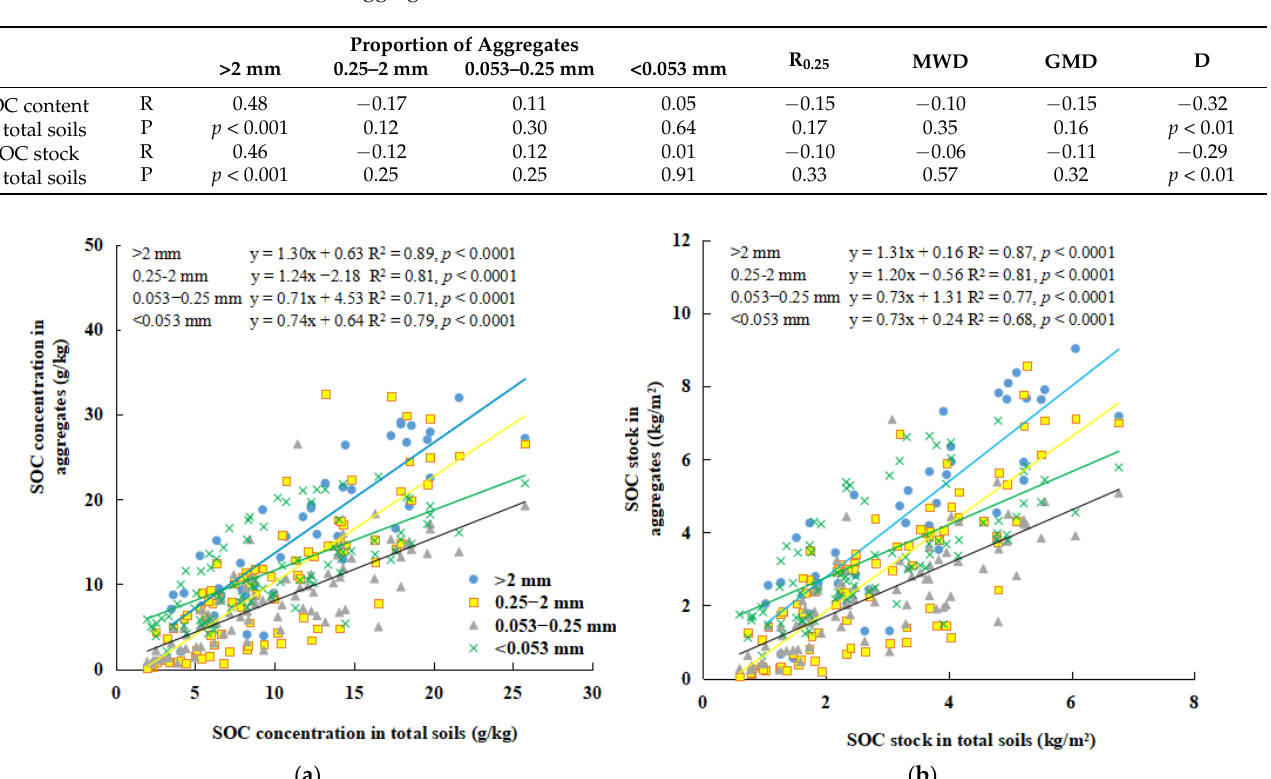
Figure 7. Relationships between SOC concentrations in total soils and in aggregates ( a ) and between SOC stocks in total soils and in aggregates ( b ).